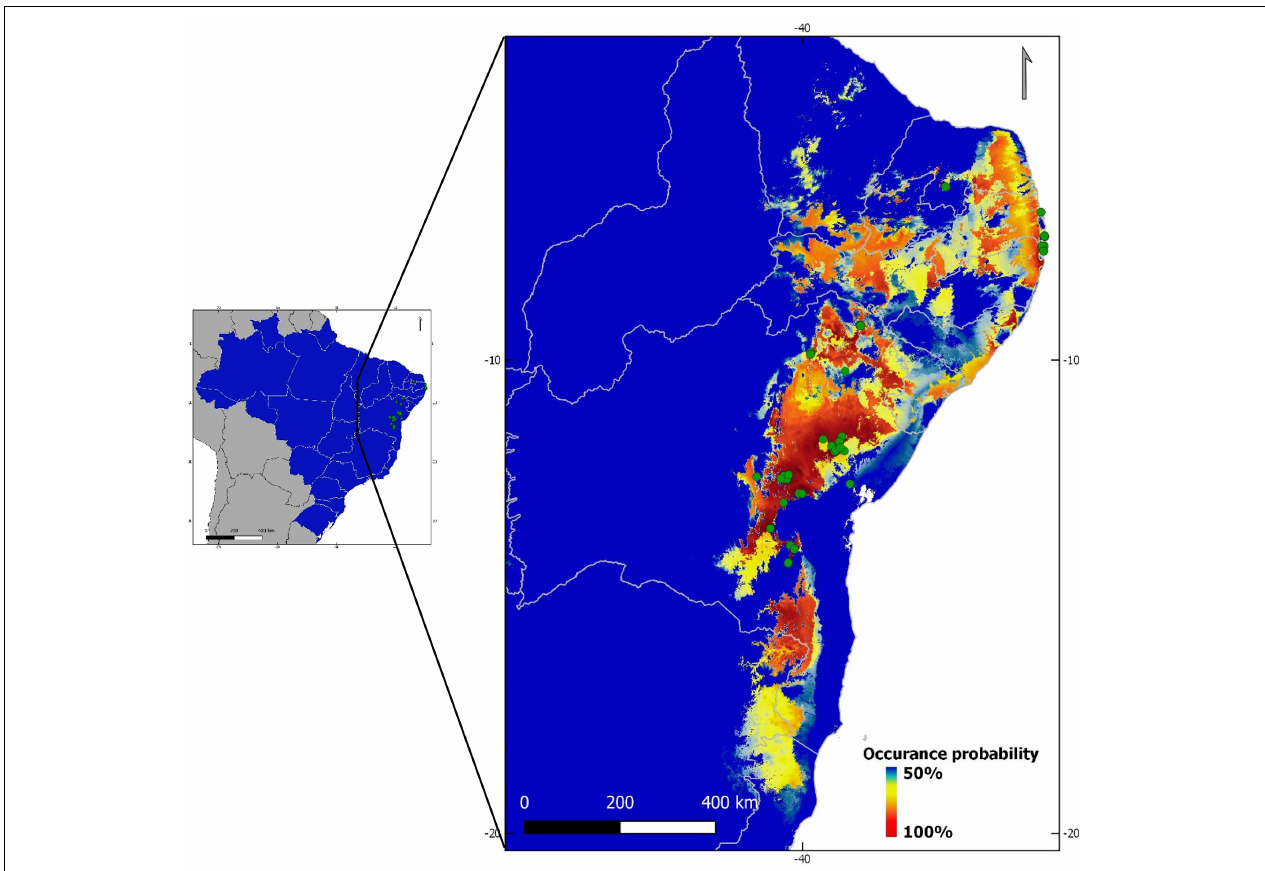
FIGURE 3 | Probability of occurrence of Gossypium mustelinum according to niche modeling.